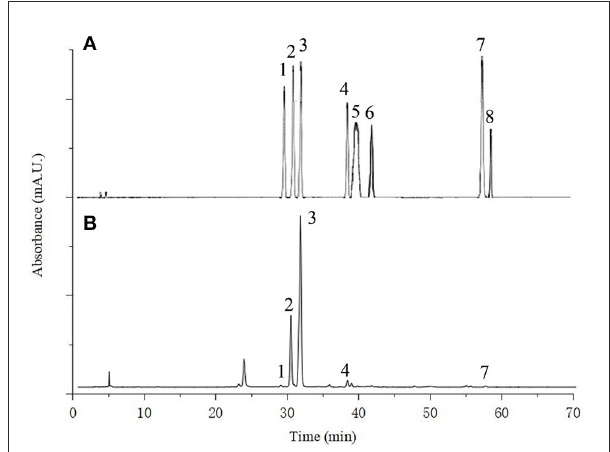
FIGURE6 The HPLC chromatogram of (A) standard mixture solution of eight flavonoids [rutin (1) hyperoside (2) isoquercitrin (3) astragaline (4); catechin (5) myricetin (6) quercetin (7) and kaempferol (8)]; (B) free phenolic of lotus leaves